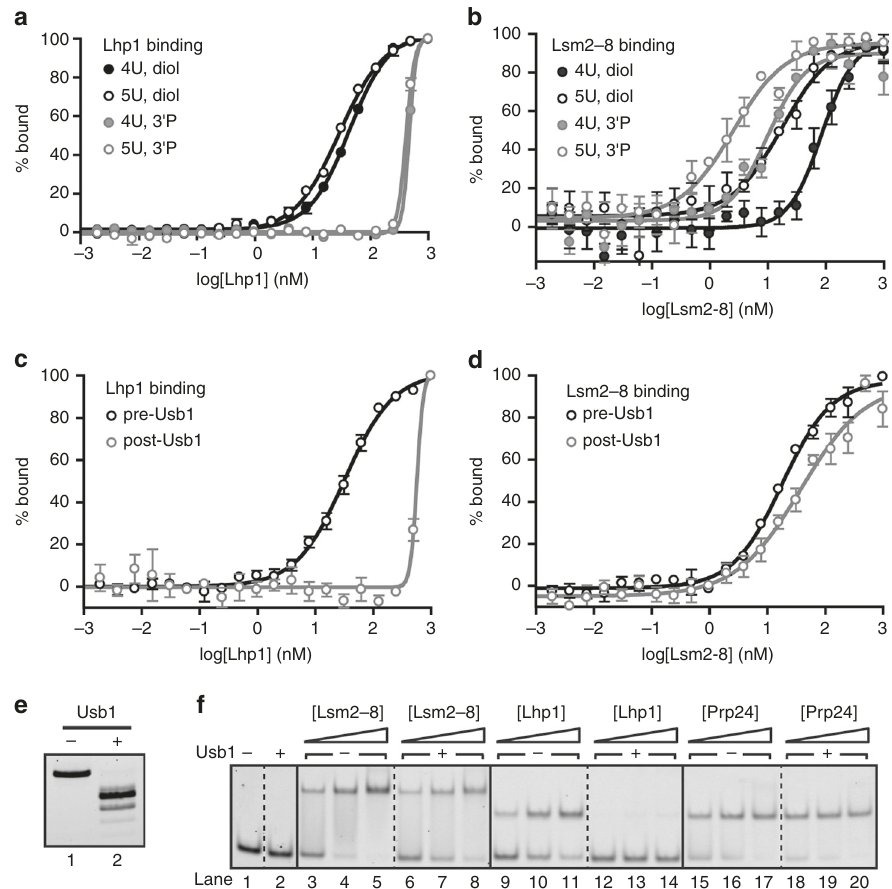
Fig. 5 Usb1 processing in fl uences RNP formation. a Fluorescence polarization binding data comparing Lhp1 binding to U6 95-112 with a cis -diol ( black , fi lled circles ), U6 95-112+1U with a cis -diol ( black , open circles ), U6 95 – 112 with a 3 ′ phosphate ( gray , fi lled circles ), and U6 95 – 112+1U with a 3 ′ phosphate ( gray , open circles ). Plotted data points represent the average of three technical replicates ± s.d. for ( a – d ). b Fluorescence polarization binding data comparing Lsm2 – 8 binding to U6 95 – 112 with a cis -diol ( black , fi lled circles ), U6 95 – 112+1U with a cis -diol ( black , open circles ), U6 95 – 112 with a 3 ′ phosphate ( gray , fi lled circles ) and U6 95 – 112+1U with a 3 ′ phosphate ( gray , open circles ). c Fluorescence polarization binding data comparing Lhp1 binding to U6 95 – 112+1U before ( black ) and after ( gray ) Usb1 processing. d Fluorescence polarization binding data comparing Lsm2 – 8 binding to U6 95 – 112+1U before ( black ) and after ( gray ) Usb1 processing. e Denaturing gel comparing RNAs used in c , d . f The af fi nities of Lsm2 – 8 and Lhp1 for full-length U6 are in fl uenced by Usb1 processing. Native gel analysis comparing Lsm2 – 8, Lhp1 and Prp24 af fi nity for U6 RNA before and after treatment with Usb1. Usb1 processing does not change the mobility of U6 on a native gel (lanes 1 vs. 2). Lsm2 – 8 binds similarly before (lanes 3 – 5) and after (lanes 6 – 8) Usb1 processing. Lhp1 binding (lanes 9 – 11) is negligible after Usb1 processing (lanes 12 – 14). Prp24 binding is unchanged before (lanes 15 – 17) and after Usb1 processing (lanes 18 –